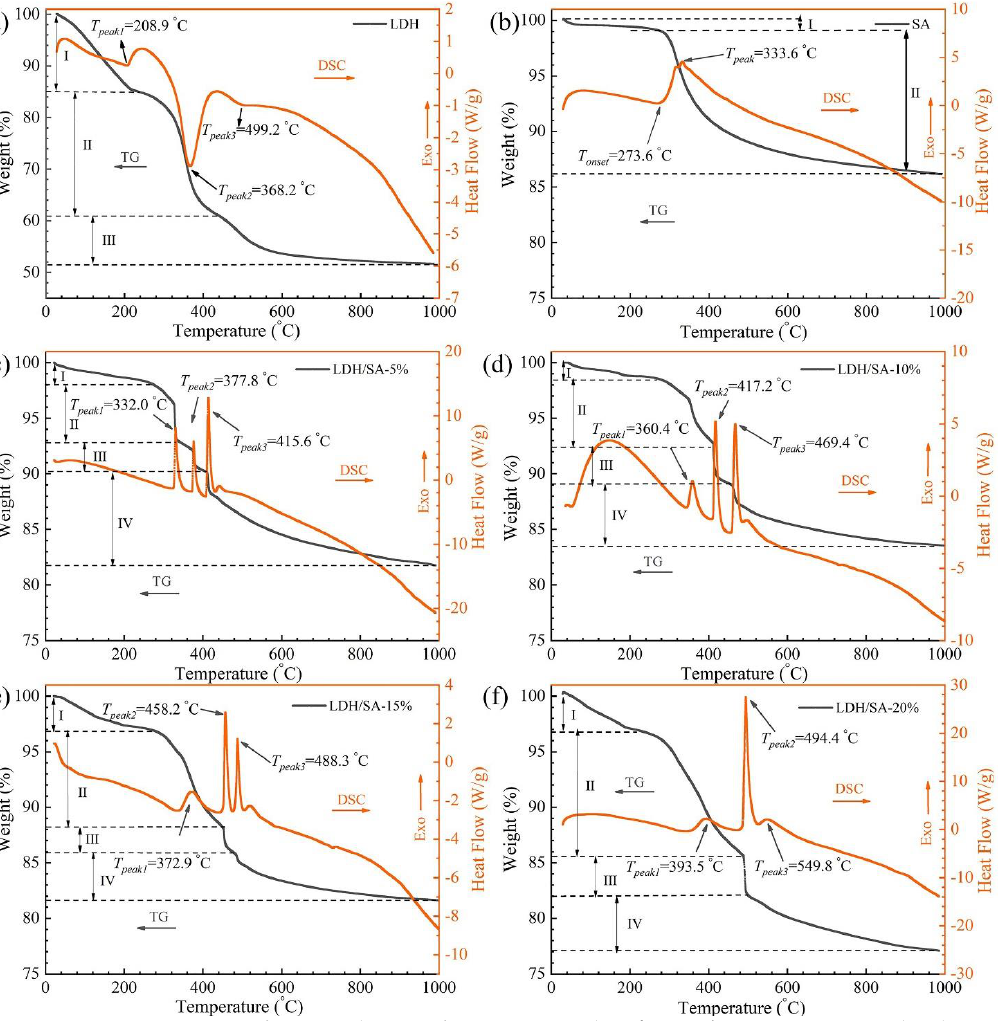
Figure 11. TG-DSC curves of ( a ) MgAl-LDH, ( b ) pure SA, and ( c – f ) LDH/SA composites under the heating rate of 10 °C/min in air. Table 2. The detailed DSC data of pure SA and LDH/SA composites.